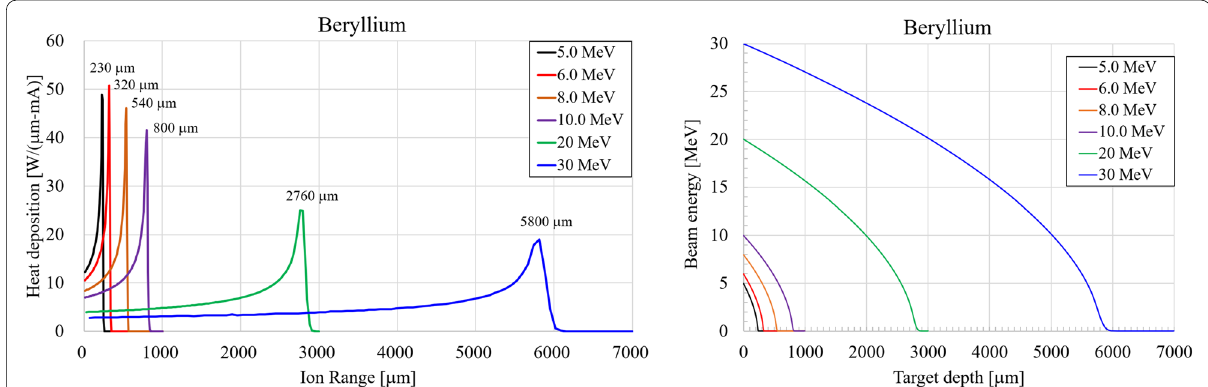
Fig. 6 (Left) Heat deposition profile of beryllium target for various incident proton beam energies. The numbers on the peak position of each profile give the Bragg peak position. (Right) The remaining beam energy along the target